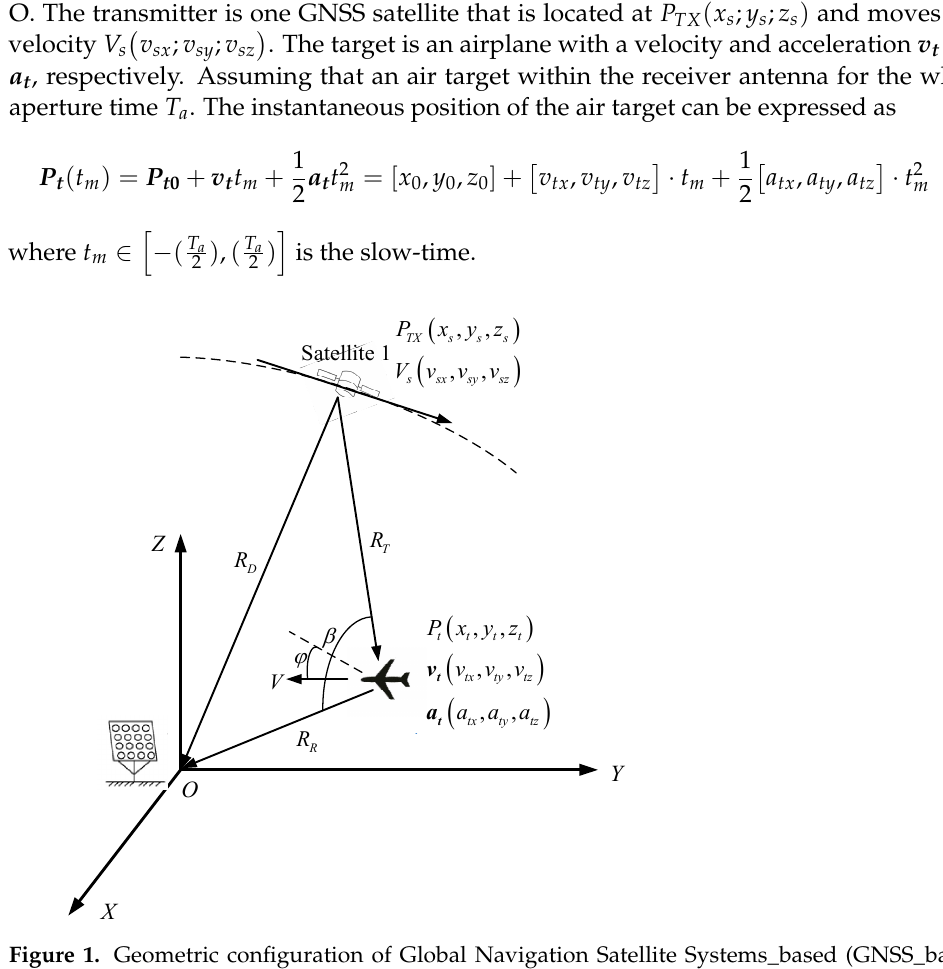
Figure 1. Geometric configuration of Global Navigation Satellite Systems_based (GNSS_based) bistatic radar.